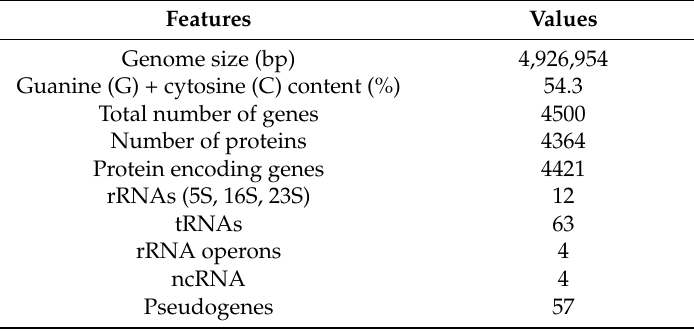
Table 1. Genome features of Pseudomonas sp. M30-35.